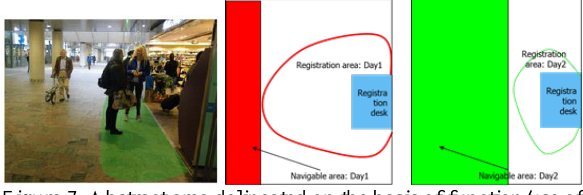
Figure 7: Abstract area delineated on the basis of function/use of the space. The function/use can change